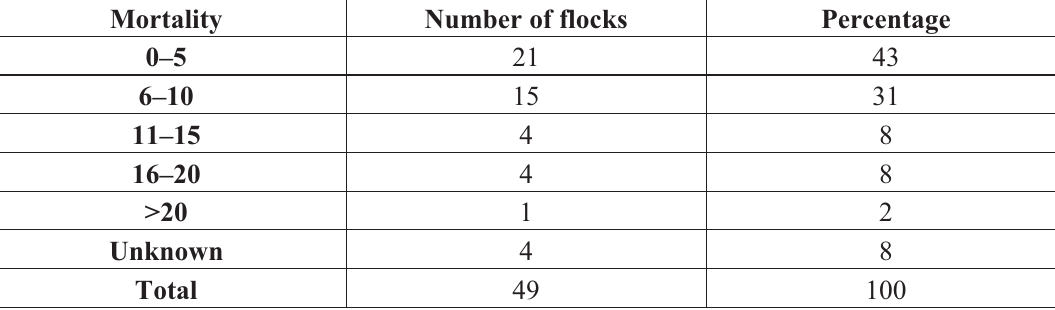
Table 6. Distribution of mortality at 60 weeks of age.